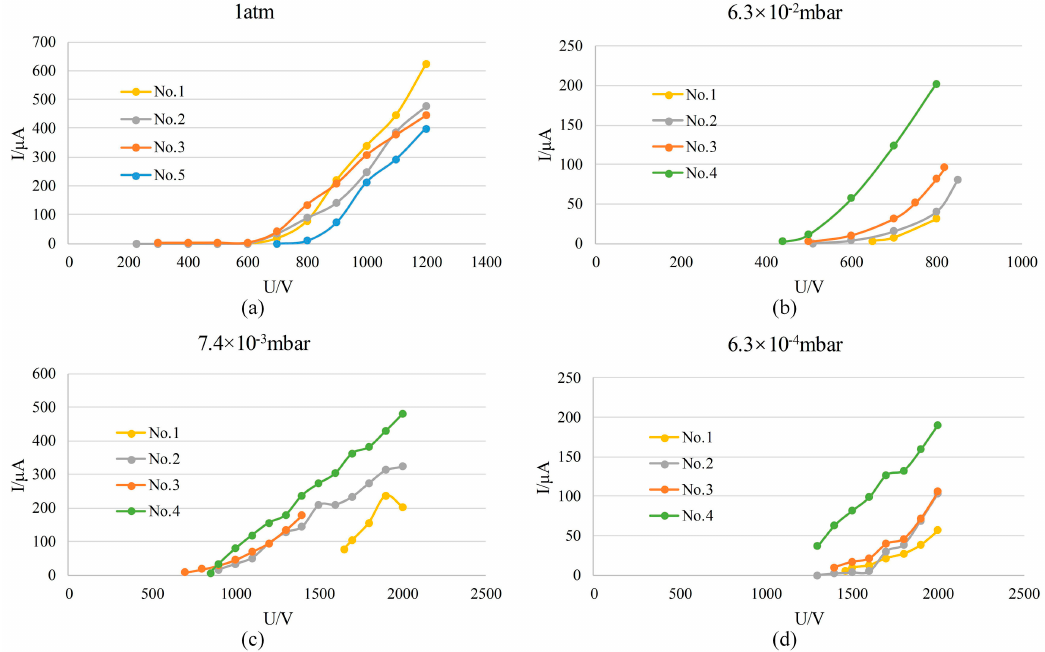
Figure 9. The discharge currents of different devices vs. voltage.